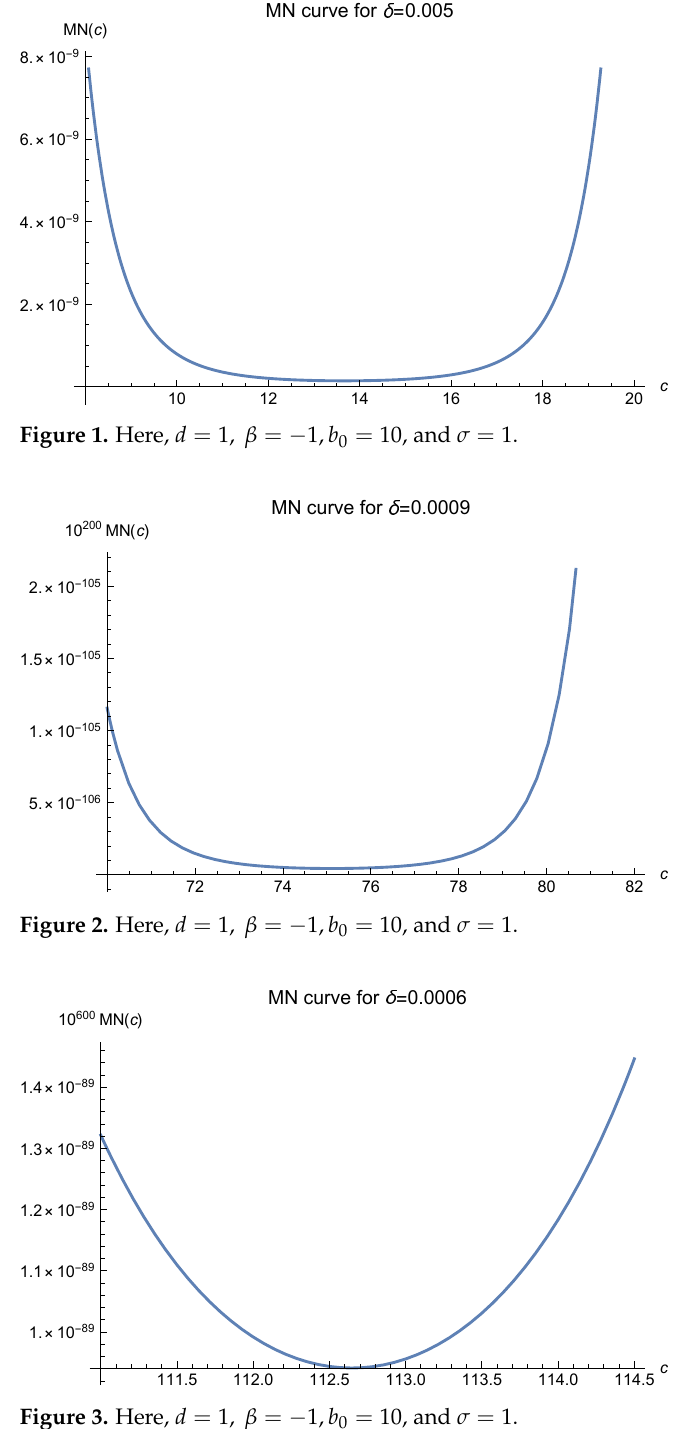
Figure 3. Here, d = 1, β = − 1, b 0 = 10, and σ =